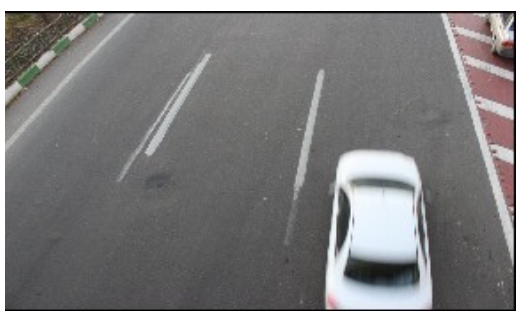
Figure2. The First image acquired in T1